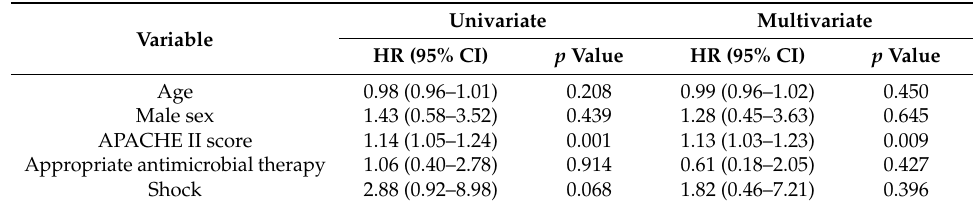
Table 6. Univariate and multivariate Cox regression analysis of risk factors for 28-day mortality among critically ill patients with CRKP